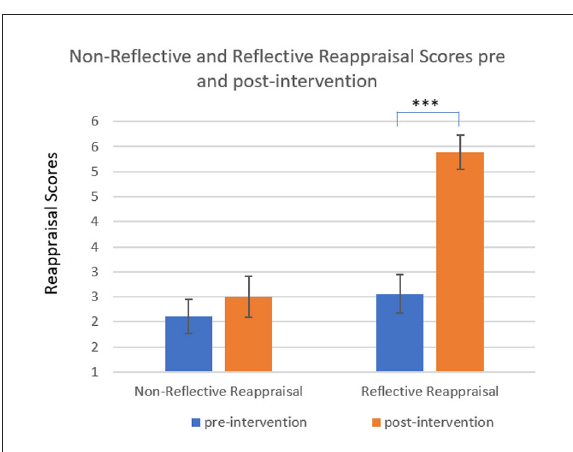
FIGURE2 Non-reflective and reflective reappraisal scores, pre and post-intervention. Results indicate a significant difference between the two time points in reflective reappraisal scores. The difference in non-reflective reappraisal scores was non-significant. *** p <